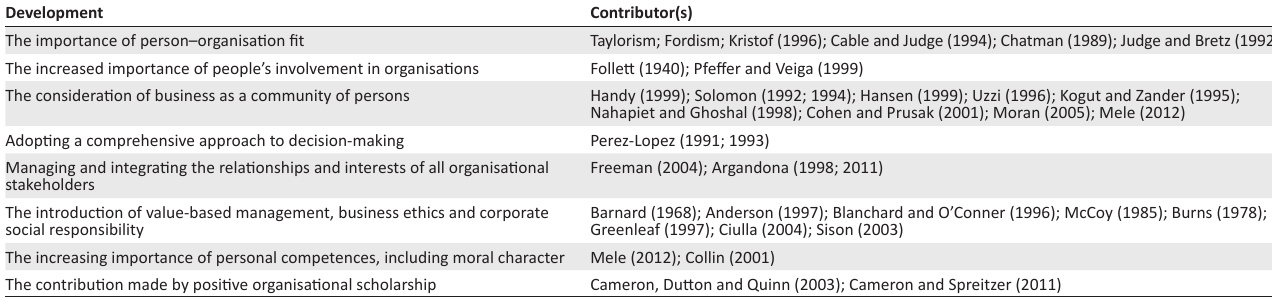
TABLE 2: Developments contributing to humanistic management. Development